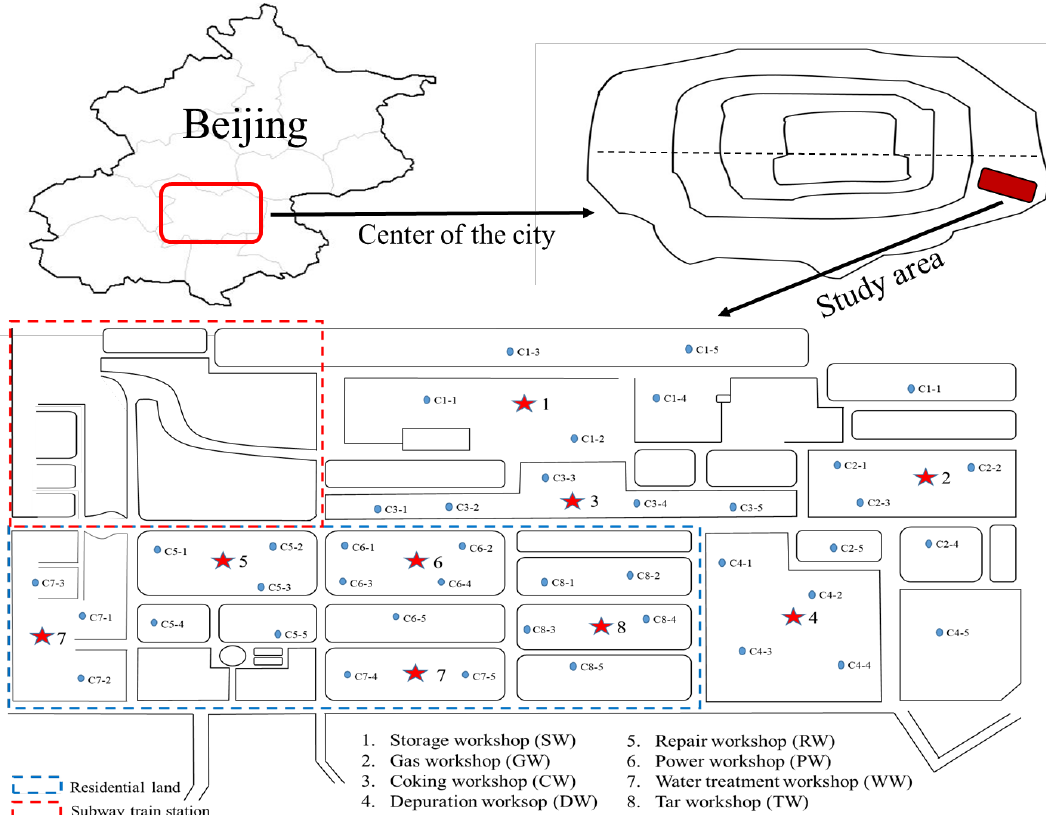
Figure 1. Schematic of sampling sites in study area, Beijing, China.